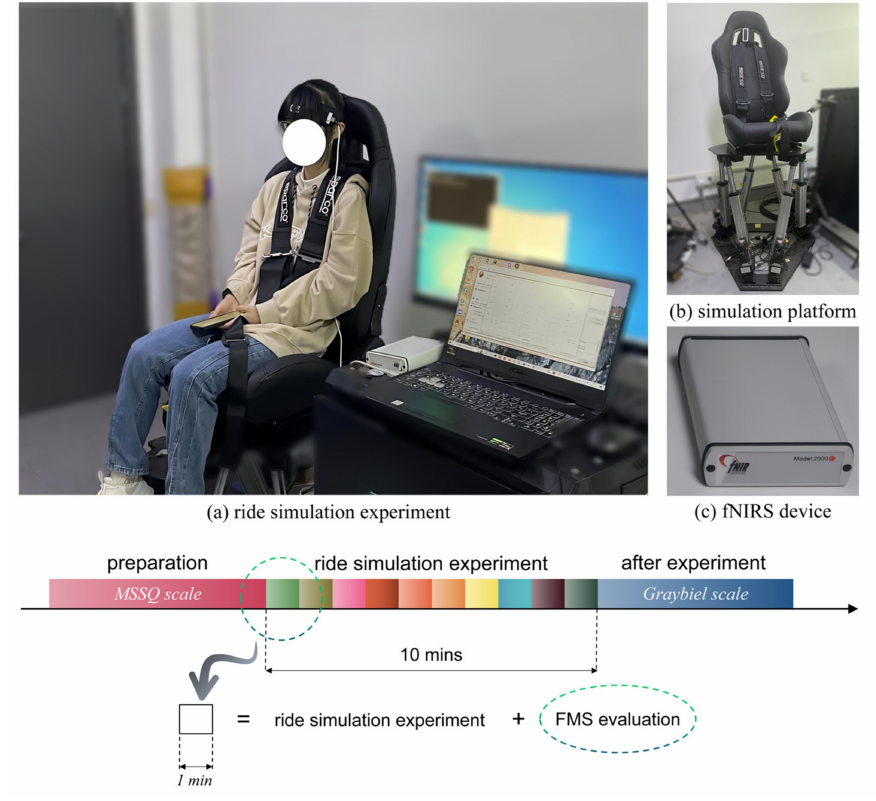
Figure 2. Experimental equipment and testing process. ( a ) ride simulation experiment; ( b ) simulation platform; ( c ) fNIRS